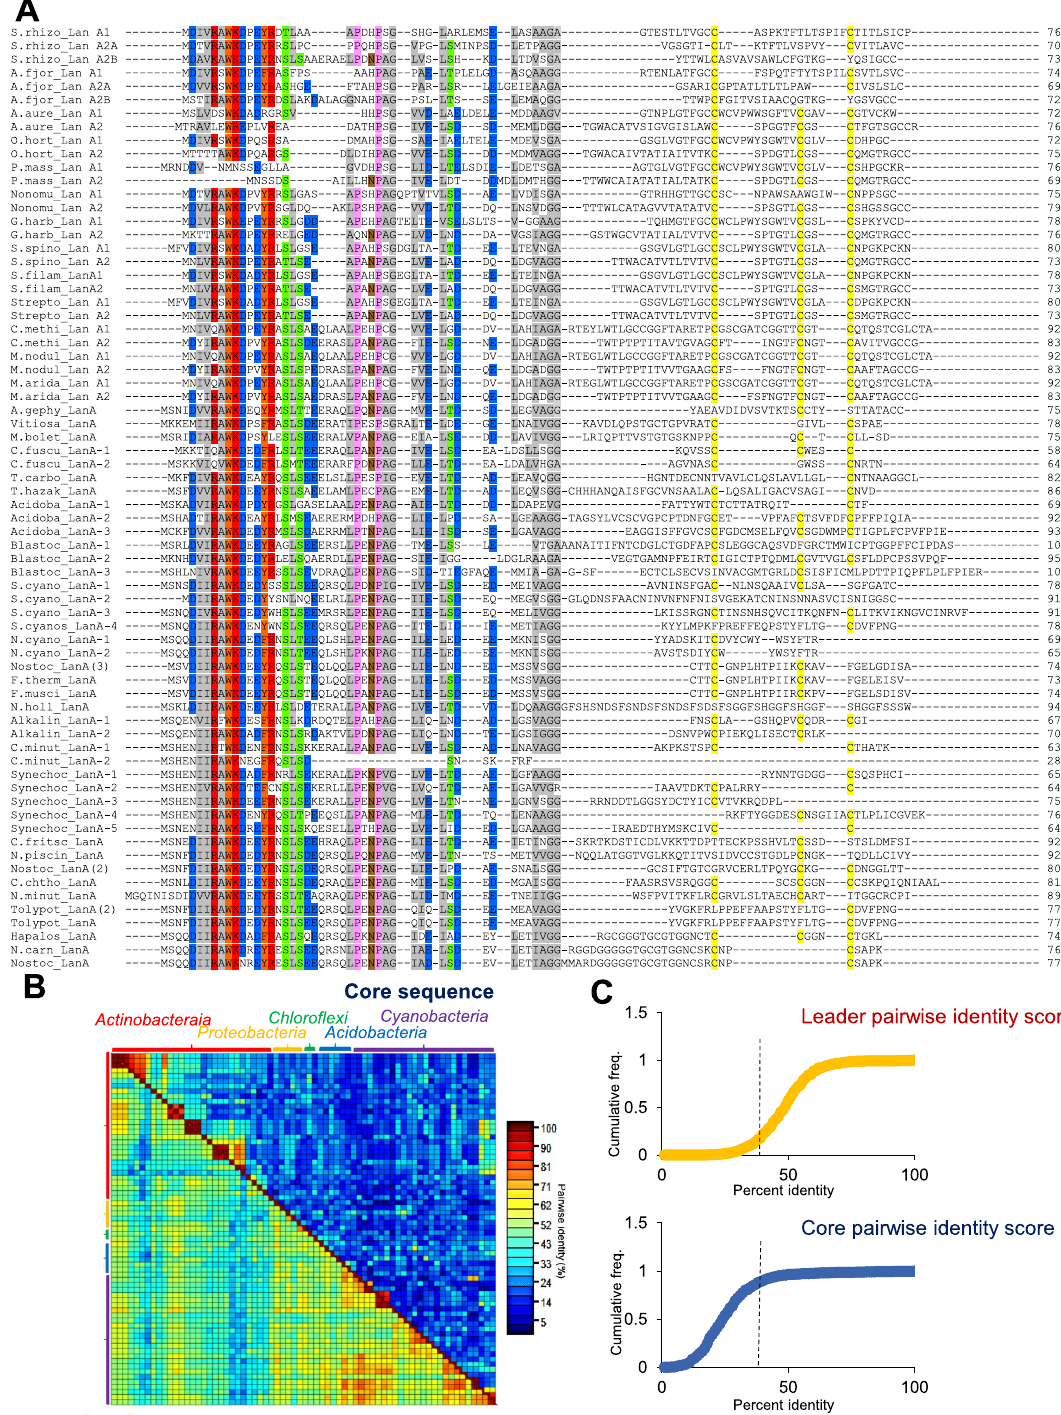
Fig. 5 Conservation of lanthipeptide leader sequence over diverse core sequences. A Multiple sequence alignment using MUSCLE of all the identified 68 precursor peptides from 42 BGCs. All leader sequences are from the NHLP family of lanthipeptide leaders. Conserved residue positions are highlighted. B Pairwise identity among 68 lanthipeptide leader sequences (lower half) and core sequences (upper half) showed high similarity among leader over core sequences (except lanthipeptide core sequences of the roseocin family having core conservation). C Cumulative frequency of pairwise sequence identity among the lanthipeptide leader and core sequences, respectively. 80% of lanthipeptide leader pairwise alignment showed > 39% identity. However, only 10% of lanthipeptide core pairwise alignment fulfilled the same criteria (mainly of the roseocin